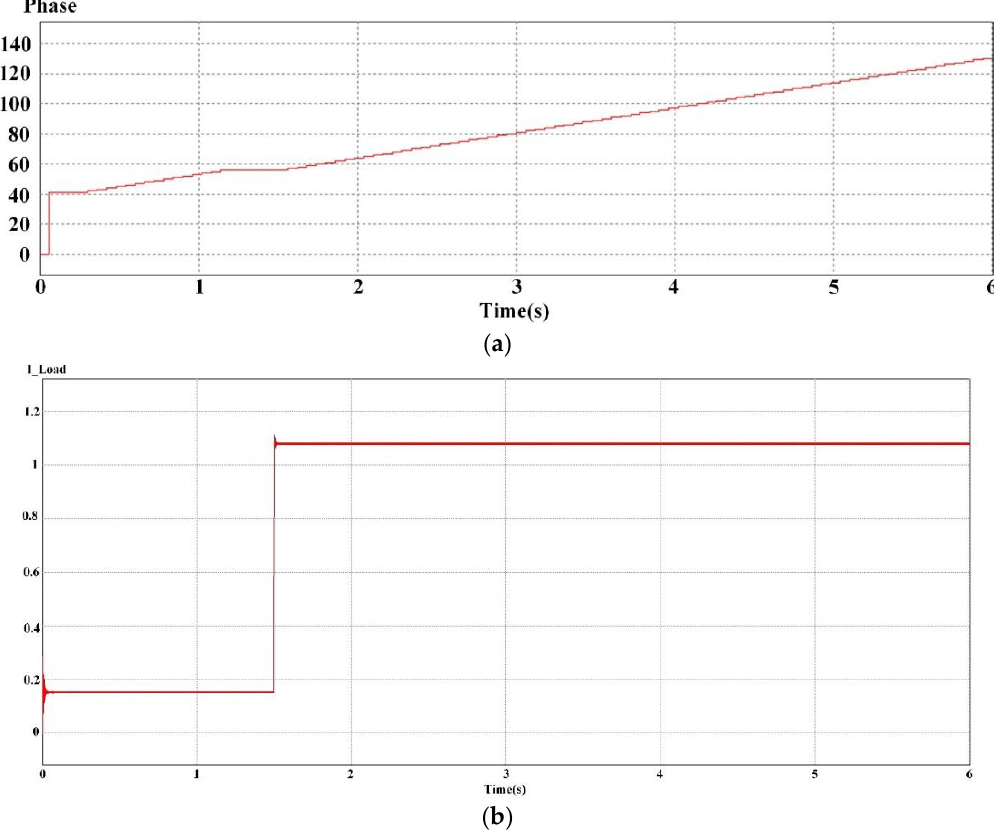
Figure 13. Simulated results of the proposed APS control method during a load change (50 W to 300 W). ( a ) Phase-shift value φ; ( b ) Load current.